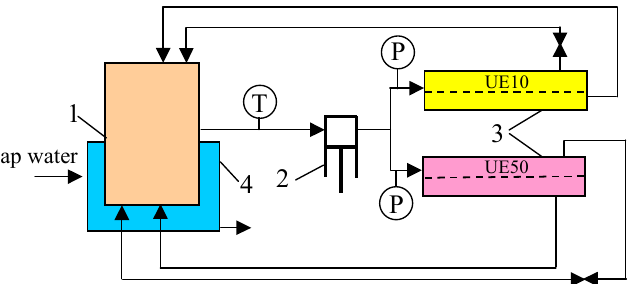
Figure 1. UF installation with two plate modules. 1—feed tank, 2—pump, 3—module, 4—water cooling, T—thermometer, P—manometer.